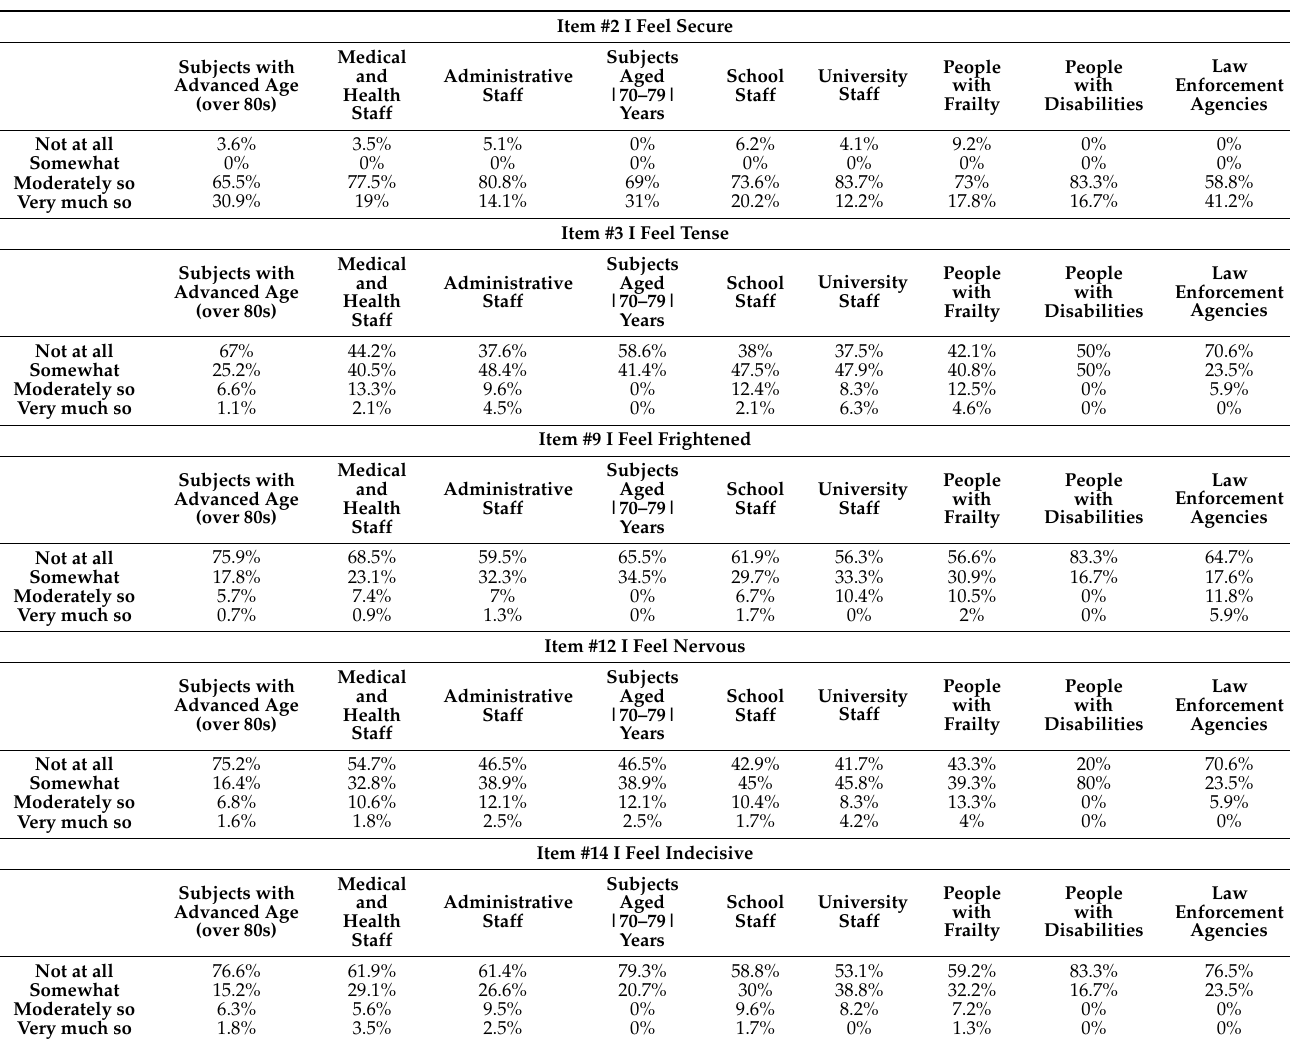
Table 7. Percentage of response frequencies related to the clinically significant items of STAI-Y divided by vaccine priority ministerial